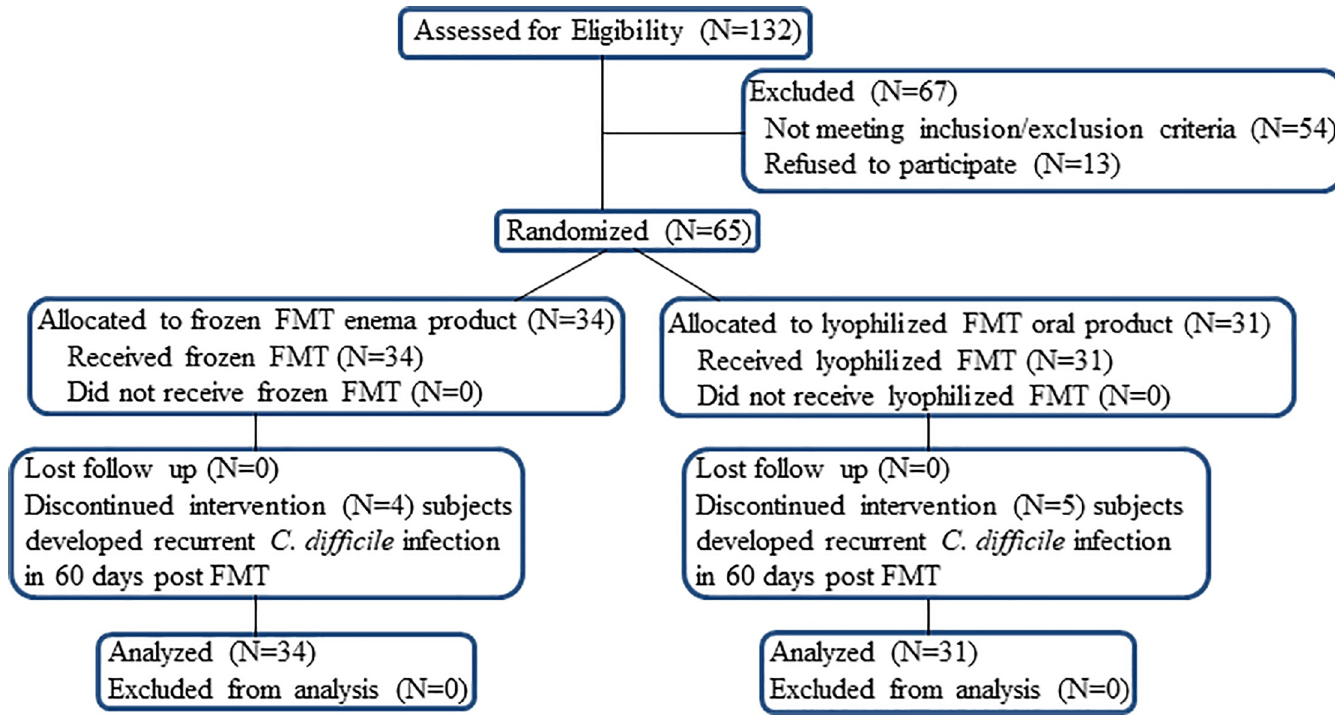
Fig 1. Subject evalation and disposition.